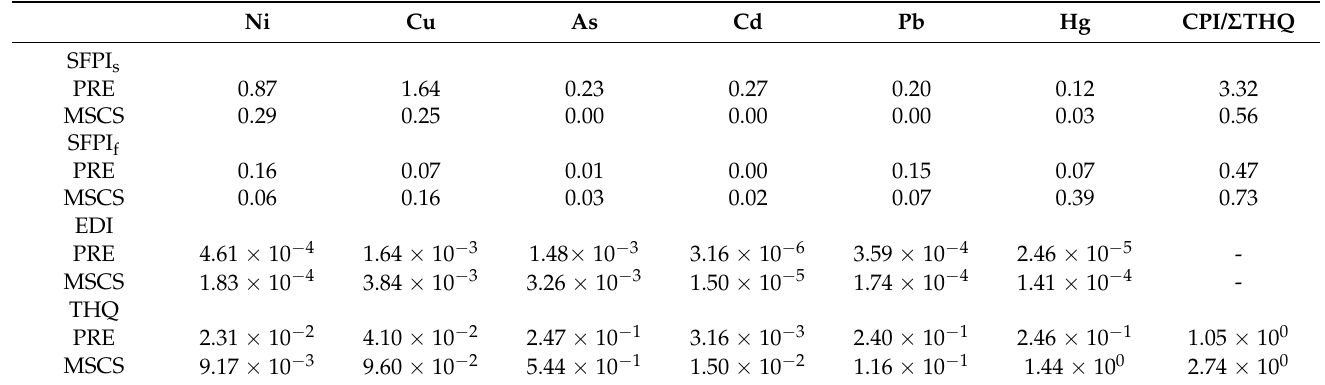
Table 2. Results of single factor pollution index (SFPI) and composite pollution index (CPI) in seawater as well as SFPI, CPI, estimated daily intake (EDI), and target hazard quotient (THQ) in fish collected from the Pearl River Estuarine (PRE) and the middle of the South China Sea (MSCS). Ni Cu As Cd Pb Hg CPI/ Σ